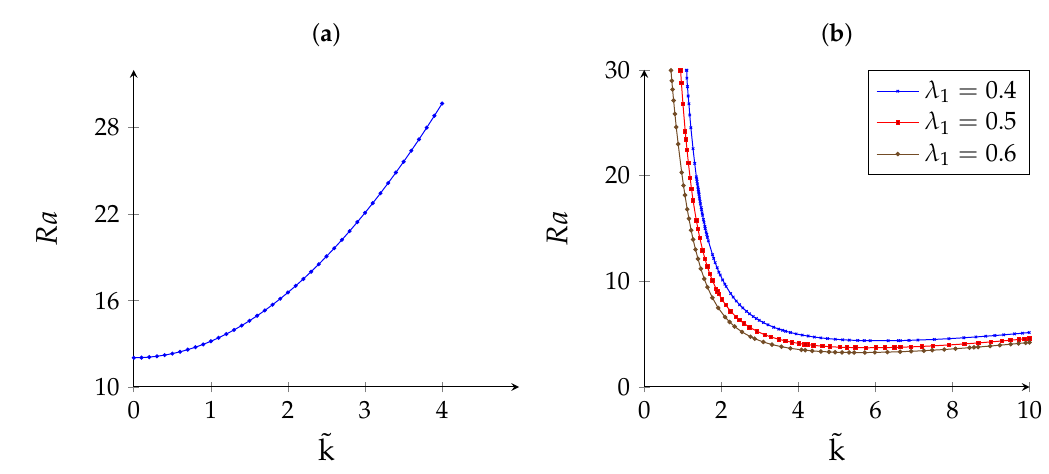
Figure 3. Neutral stability curves: ( a ) stationary instability, which exists independently of viscoelastic parameters; ( b ) oscillatory instability, which may develop first depending on viscoelastic parameters.